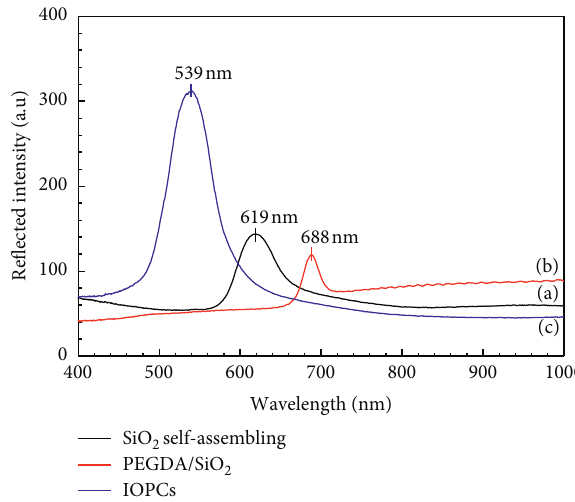
Figure 3: Reflection spectra for SiO 2 self-assembling (curve (a)), PEGDA/SiO 2 (curve (b)), and the IOPCs (curve (c)).